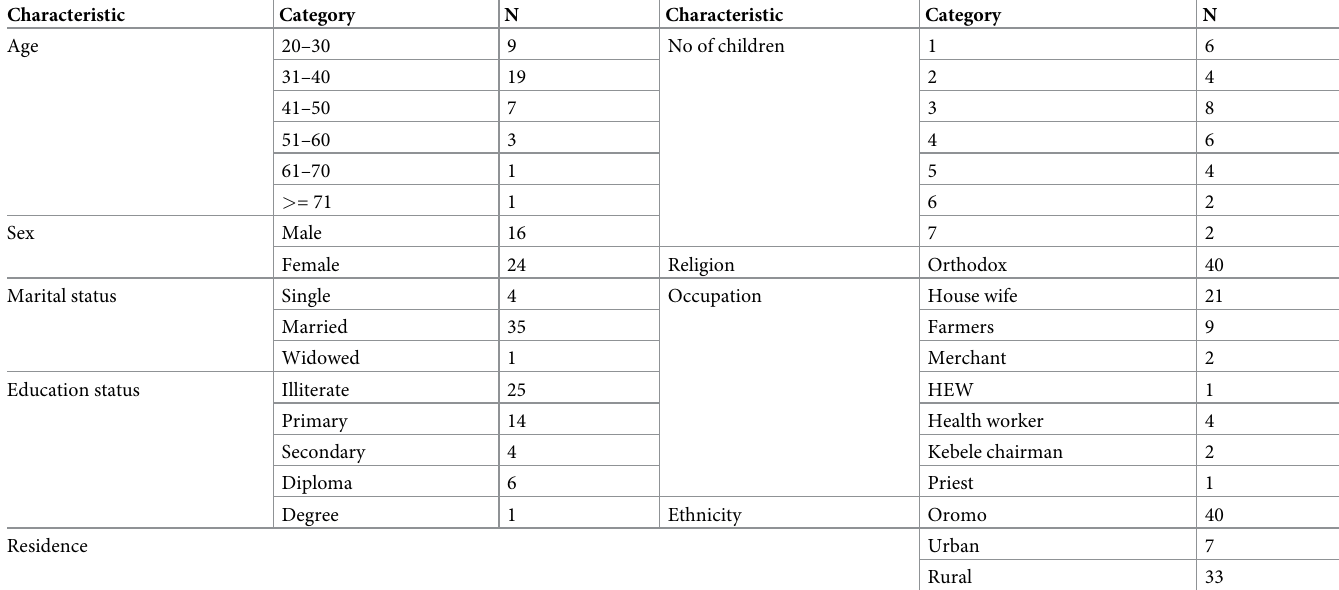
Table 1. Demographic characteristic of participants in Debre Libanos District, North Shoa, Oromia, Ethiopia, 2019.